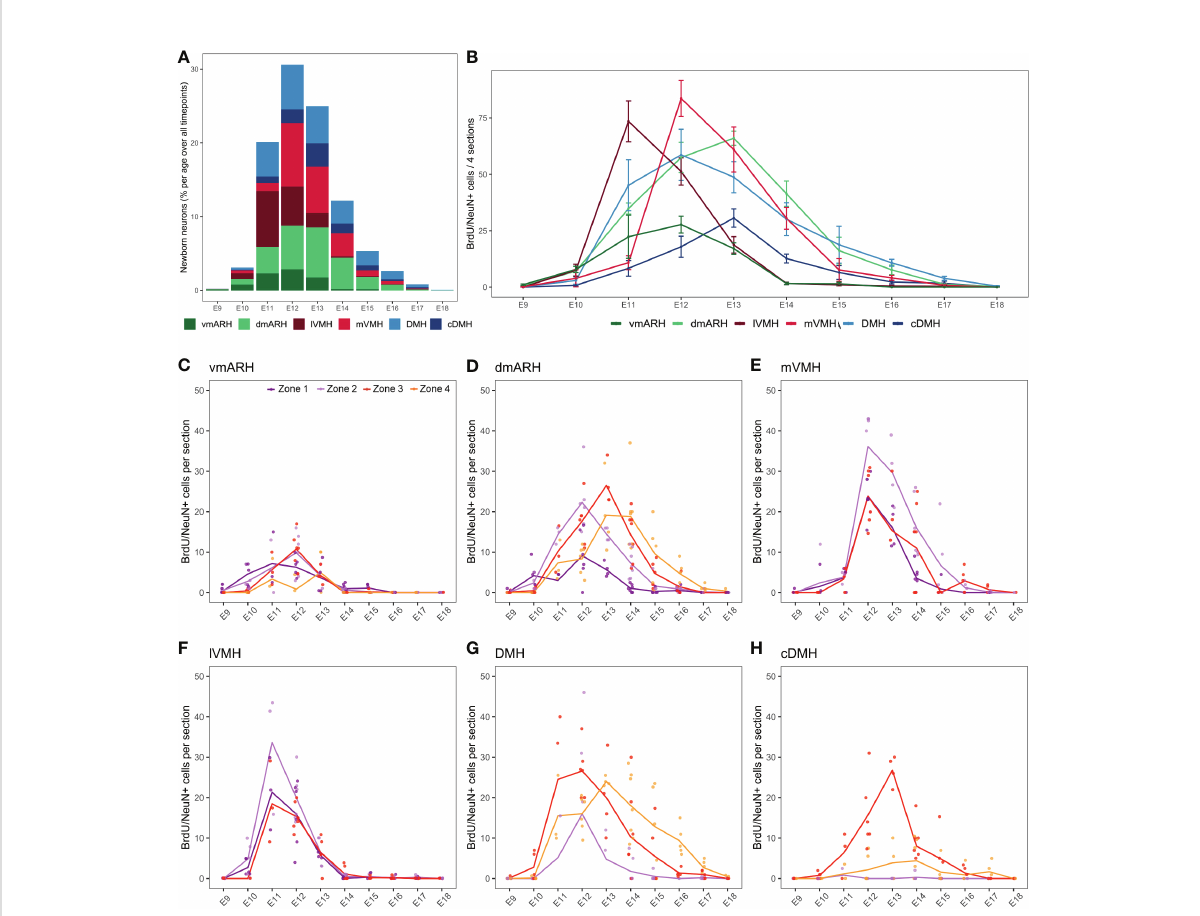
FIGURE 4 Developmental hypothalamic BrdU incorporation in NeuN-positive cells. (A) Stacked graph displaying the proportion of newborn BrdU/NeuN- positive cells in the hypothalamic regions vmARH, dmARH, lVMH, mVMH, cDMH, and DMH per age over all analyzed brains from P21-22 animals having received a single BrdU injection from E9 to P8 ( e.g. , “ E9 ” brains were harvested from P21-22 male pups whose mothers received a single BrdU injection during pregnancy at E9; “ E10 ” brains were harvested from P21-22 male pups whose mothers received a single BrdU injection during pregnancy at E10 … ). The bars represent the percentage of cells per age over the whole analyzed period. Within a single age, the colors represent the percentage of cells per nucleus over the entire analyzed region. (B) Number (mean ± SEM) of BrdU/NeuN-positive cells per nucleus and per age over 4 hypothalamic sections (one in each rostrocaudal zone). (C – H) Number (average -line- and individual values -dots-) of BrdU/NeuN-positive cells per rostrocaudal zones (1 to 4) and per age in each hypothalamic region. n=3 to 7 animals per group. vmARH, ventromedial arcuate nucleus of the hypothalamus; dmARH, dorsomedial arcuate nucleus of the hypothalamus; lVMH, lateral ventromedial nucleus of the hypothalamus; mVMH, medial ventromedial nucleus of the hypothalamus; cDMH, compact dorsomedial nucleus of the hypothalamus; DMH, dorsomedial nucleus of the hypothalamus. See Figure